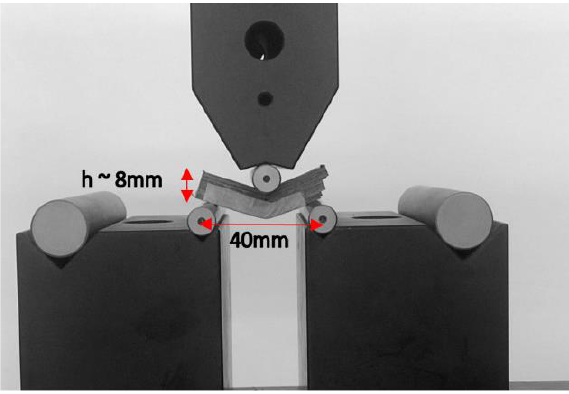
Figure 1. Shear test as per ASTM-D2344. Force and deflection for all tested samples were recorded, and diagrams similar to Figure 2 were attained.